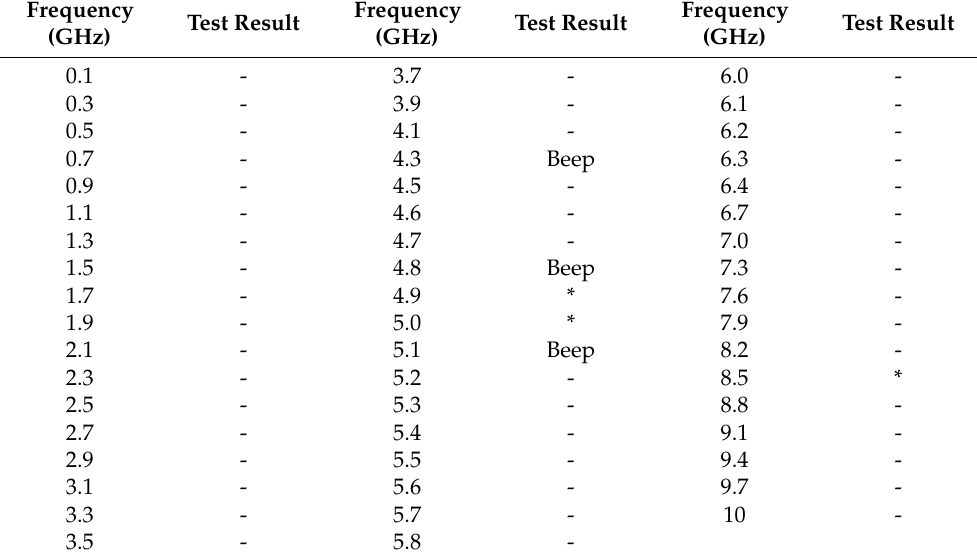
Table 4. The results of the irradiation test for each frequency point of the simulated product without absorbing material (800